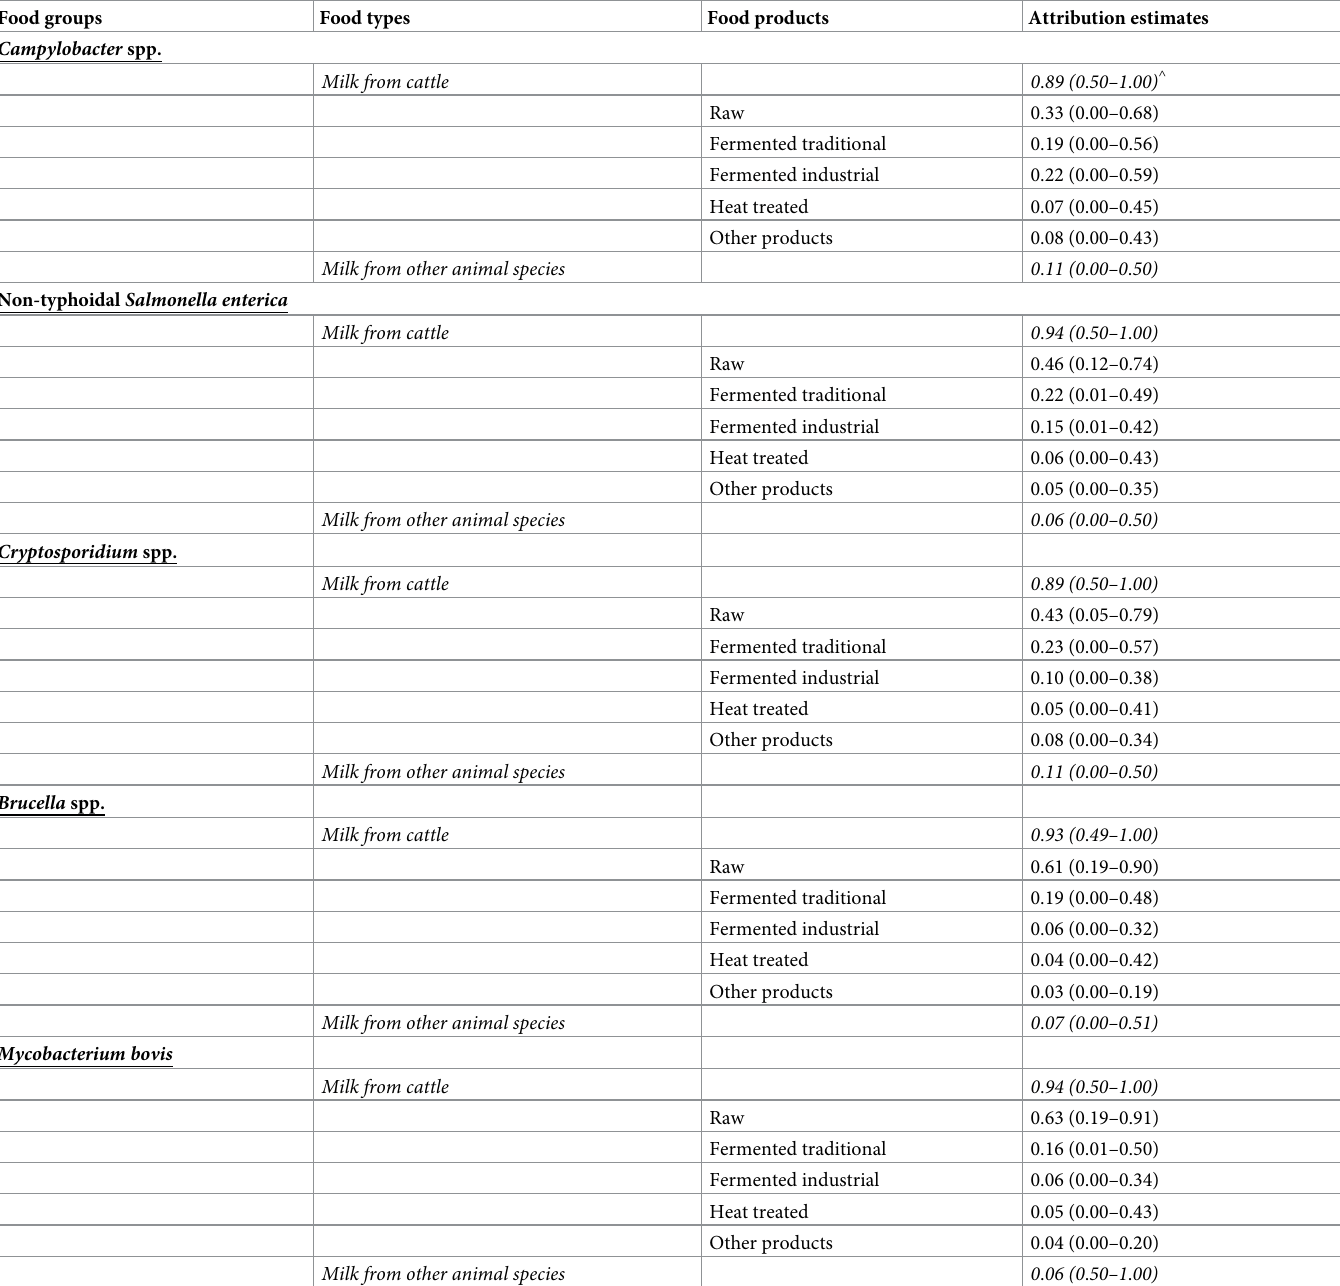
Table 8. Attribution of foodborne disease due to five dairy-associated hazards in Rwanda to dairy food types, and food products. Food groups Food types Food products Attribution estimates Campylobacter